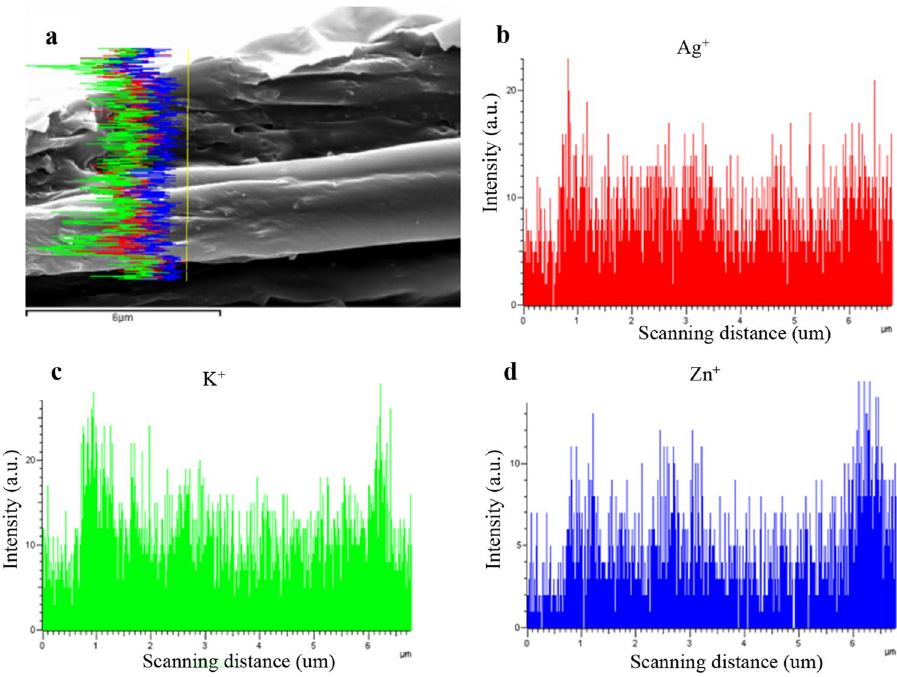
Figure 3. SEM micrograph ( a ) and EDS curve showing silver ( b ), potassium ( c ), zinc ( d ) distribution on coverslips of AgNPs-PL.